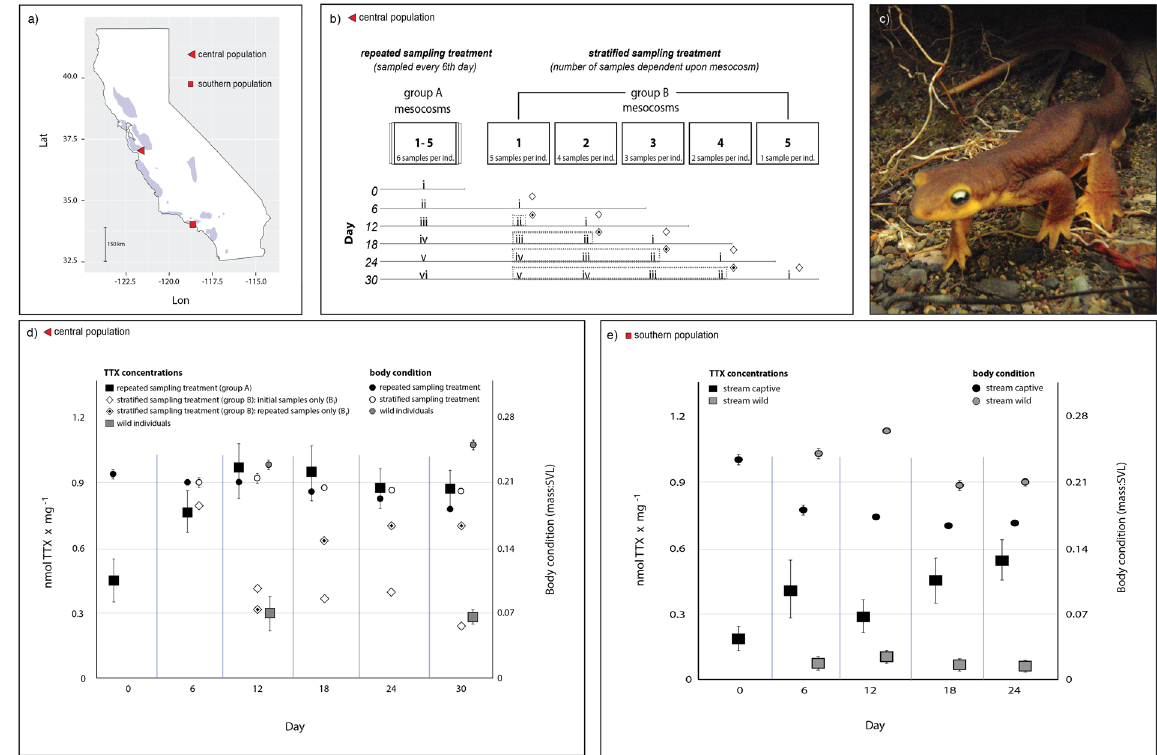
Figure 1. Changes in chemical defense concentrations of toxic newt populations in California. (a ) A map of California created in R 61 using ggplot2 (v.2.20) 64 shows the current distribution of the focal species, Taricha torosa and marked locations of the study populations. ( b ) A schematic of the experimental sampling design for the ex situ experiment with newts from central California. Time is represented from day 0–30 and is associated with a horizontal line to show which individuals in a group were sampled on that day. Roman numerals represent the sample number and indicate whether the sample is initial (i) or a repeat (ii–vi) for newts in the stratified sampling experiment (group B). Diamonds represent initial samples (hollow) or repeated samples (dotted) and correspond to data in panel d. Dotted lines encompass the mean values depicted in panel d. ( c ) An underwater image of a breeding male California newt (photo by G.M. Bucciarelli). ( d ) The mean body condition and TTX concentrations (nanomoles mg − 1 tissue, ± s.e.m.) of experimentally sampled and wild newts from the central California population during the ex situ experiment show that chemical defenses increased rapidly as a result of repeated sampling. Mean chemical defenses of the repeatedly sampled newts in group A ( P = 0.01) and repeatedly sampled newts in group B (B r - mean values encircled within dashed boxes in panel b and marked with dotted diamonds in panel b) increased significantly through time ( P = 0.02) whereas mean chemical defenses of initially-sampled individuals from the stratified sampling treatment (B i , mean values; marked in panel b with hollow diamonds) did not significantly increase ( P = 0.10) or differ from wild, non-captive individuals ( P = 0.12). Mean body condition values ( ± s.e.m.) of captive and non-captive newts suggest potential costs associated with increased chemical defenses, but the predictor was not significant ( P = 0.91). ( e ) Adult male mean TTX concentrations ( ± s.e.m.) of in situ newts from the southern California population significantly increased through time ( P = 0.004) and chemical defenses significantly differed relative to cohabitating wild, non-captive newts sampled on the same day ( P = 0.01). Although notably different, body condition ( ± s.e.m.) was not a significant predictor ( P = 0.098). Vertical blue bars in both panels d and e separate data of each sampling